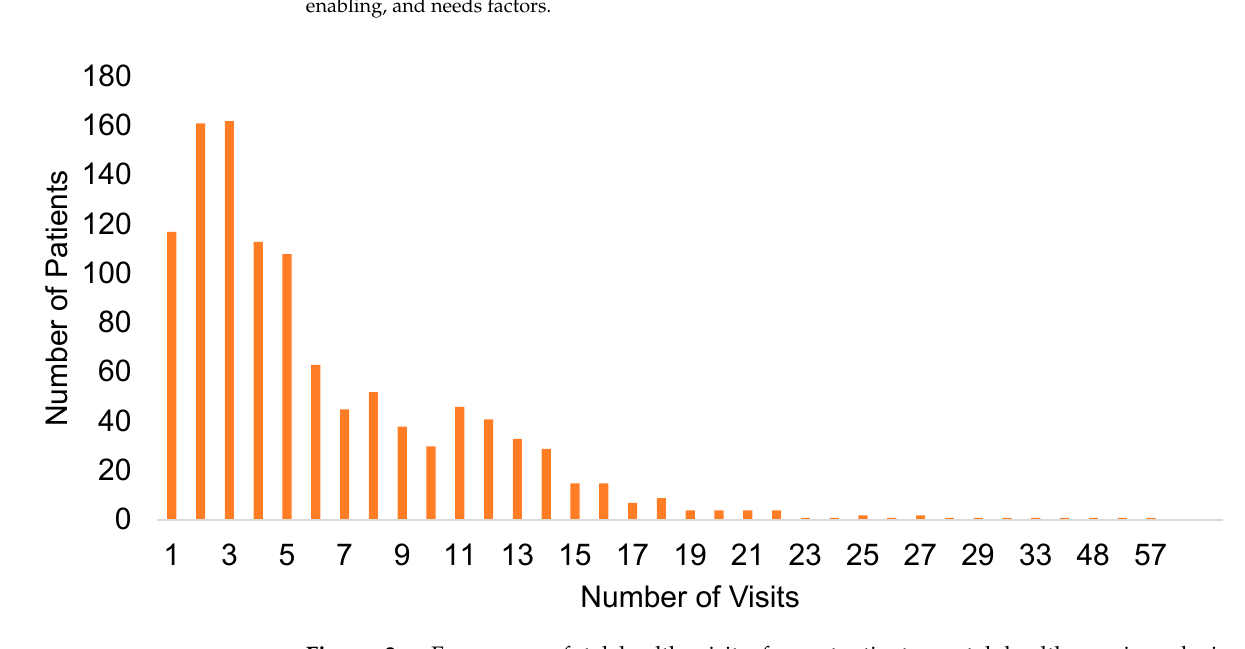
Figure 2. Frequency of telehealth visits for outpatient mental health services during the COVID-19 pandemic.